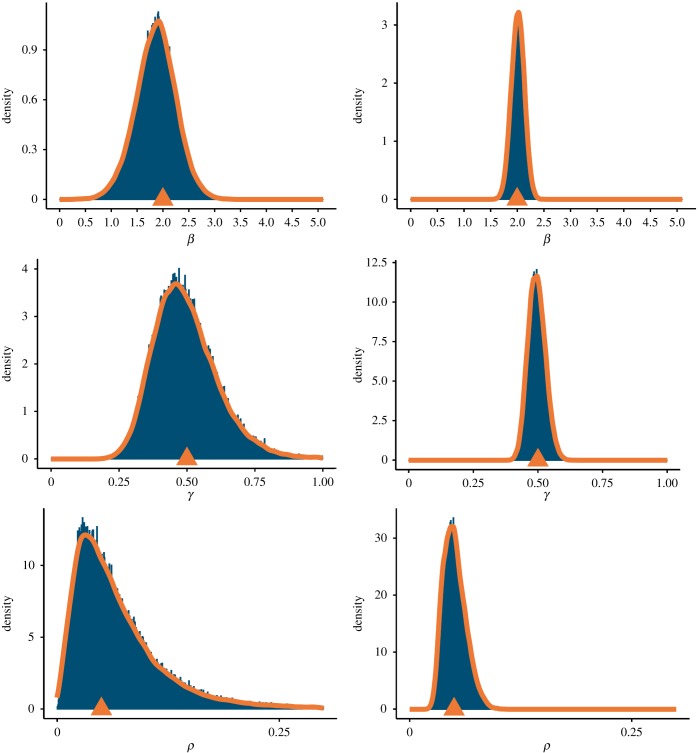
The posterior distributions of the Method 3 estimators of β, γ and ρ based on the SDS likelihood for the smaller cut-off time (T = 3). The left-hand panels correspond to n = 102, and the right-hand panels correspond to n = 103. The true parameter values are β = 2, γ = 0.5 and ρ = 0.05 (parameter setting θ1). (Online version in colour.)